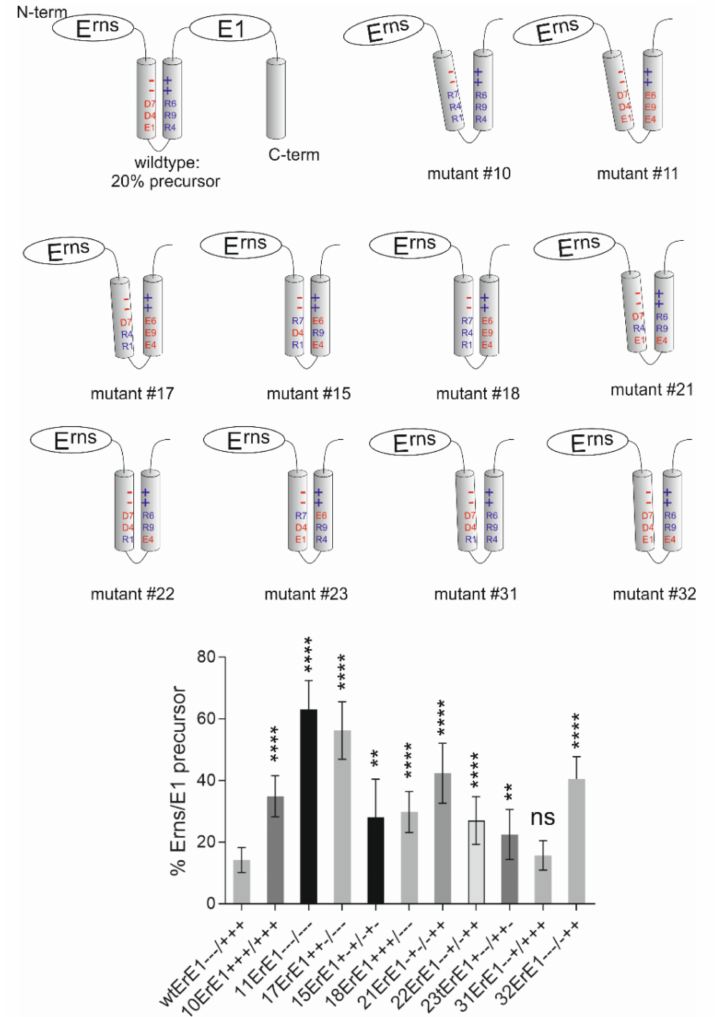
Figure 4. Effect of mutations of the conserved inner six charged residues in the E rns carboxy-terminal helix on E rns -E1 processing. The upper part shows a schematic presentation of the mutants in the putative charge zipper region of E rns . Amino acids are as described above (D7 = Asp177, D4 = Asp184, E1 = Glu191, R4 = Arg194, R9 = Arg199, and R6 = Arg206). Red color symbolizes negative charge (also indicated by “-“), and blue color positive charge (also indicated by “+”). The tilted helices shown for mutants 10 ErE1, 11 ErE1, 17 ErE1, 21 ErE1 and 32 ErE1 indicate the different degree of repulsion induced by the charge changes. The bar diagram summarizes the results of immunoprecipitation experiments after expression of E rns -E1 with the mutations shown above. The numbers of the constructs together with the charge distribution patterns are indicated at the X-axis. The bars represent the percentage of uncleaved E rns -E1 precursor determined in at least three independent experiments. The calculation principle is described in Materials and Methods section. Error bars are indicated and the p -Values for the results determined for the mutants with respect to the wt E rns -E1 are indicated by asterisks. Significant differences of the E rns -E1 processing rate were observed for constructs